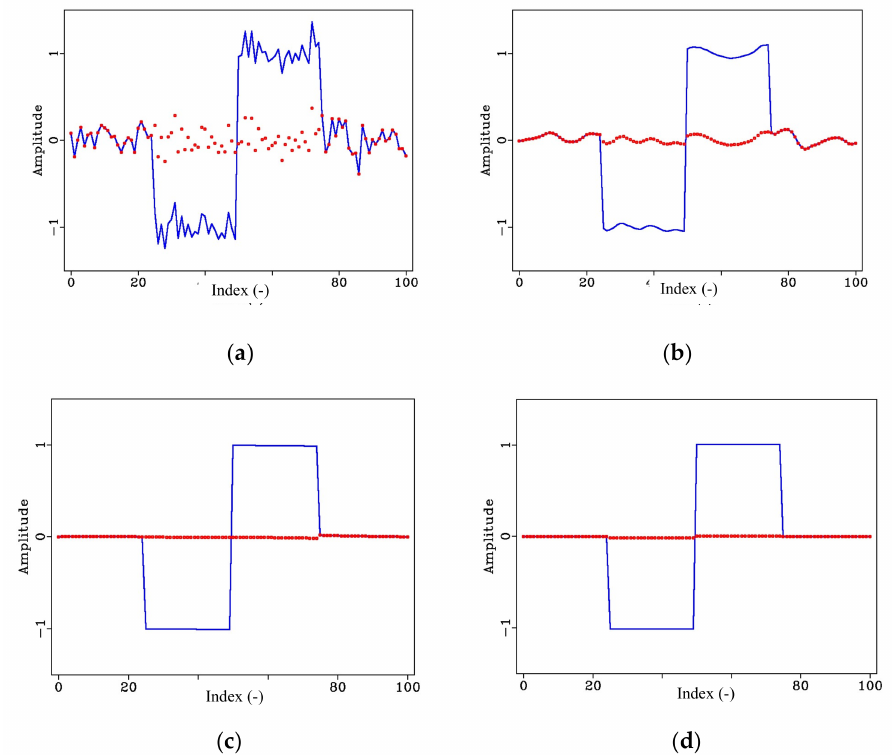
Figure 2. E ff ect of bilateral filter on synthetic signal with three di ff erent sets of parameters: ( a ) Synthetic square wave signal with added random noise; ( b ) filtered signal using R = 3, σ d = 5, and σ r = 0.05; ( c ) filtered signal using R = 5, σ d = 10, and σ r = 0.1, and ( d ) filtered signal using R = 15, σ d = 10, and σ r = 0.1. The dotted red line represents the residual